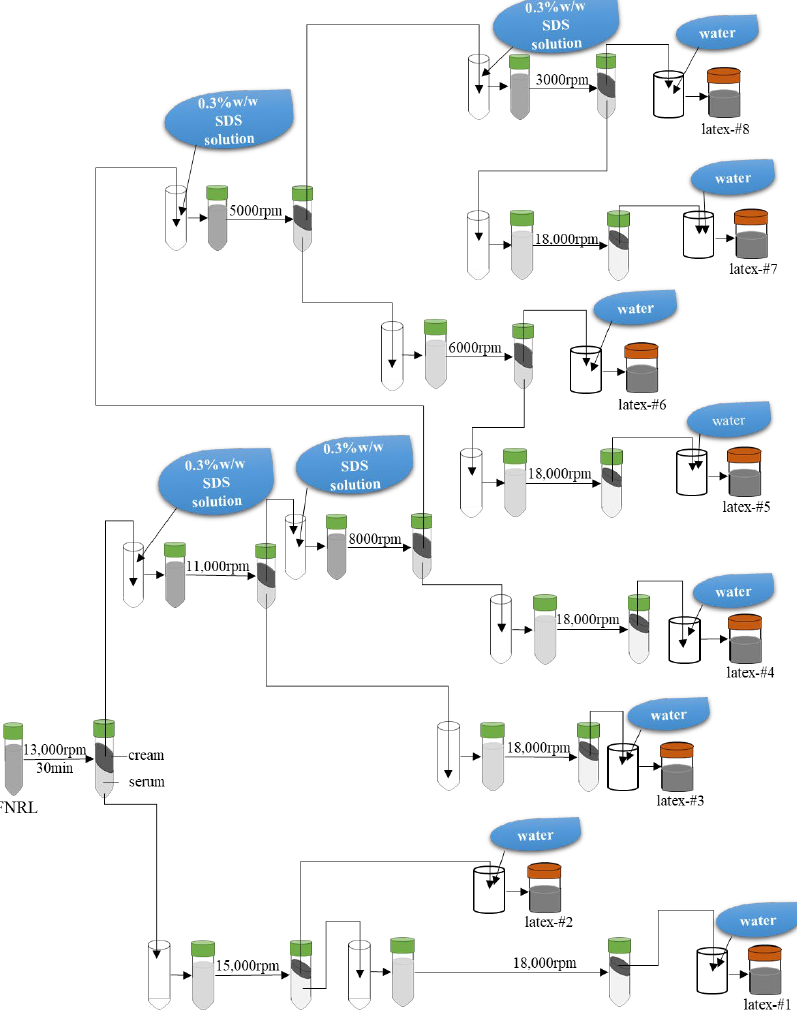
Figure 10. Fractionation process of FNRL by centrifugation at different revolving speed rates.